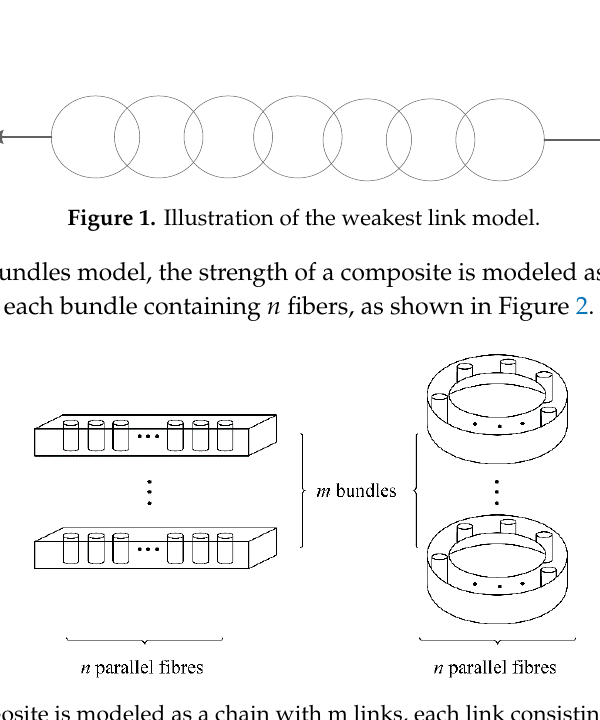
Figure 3. Sketch of a two-element parallel system.